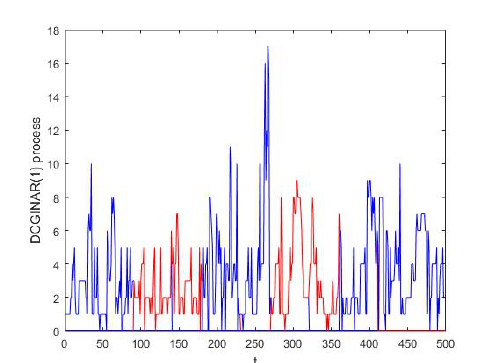
Figure 2. The overlapped segments for the same simulated series of the DCGINAR(1) model at n = 90, q = 50 and L =